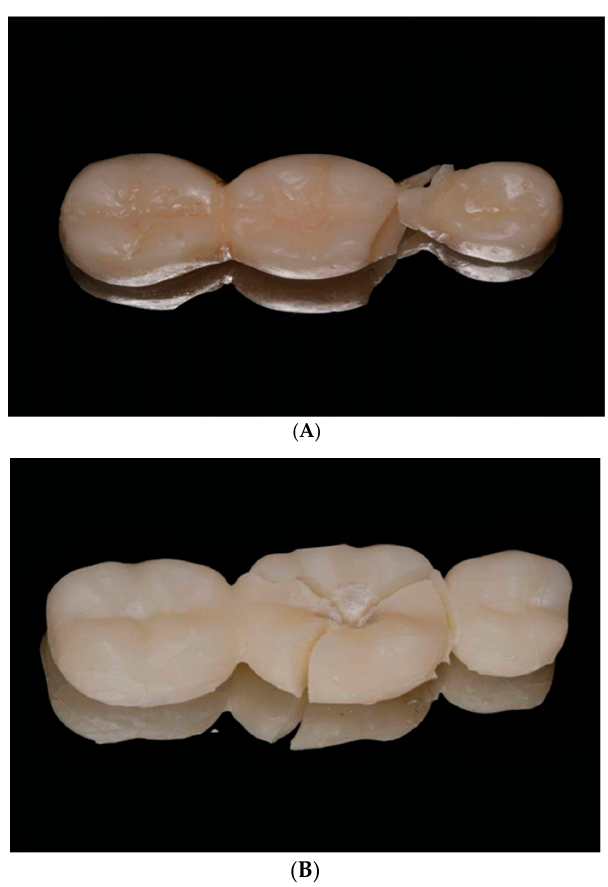
Figure 7. ( A ) Fracture pattern of IFDP on connectors among milled, DLP AS and conventional samples. ( B ) Fracture pattern of IFDP on pontic and connector regions among SLA ND samples.